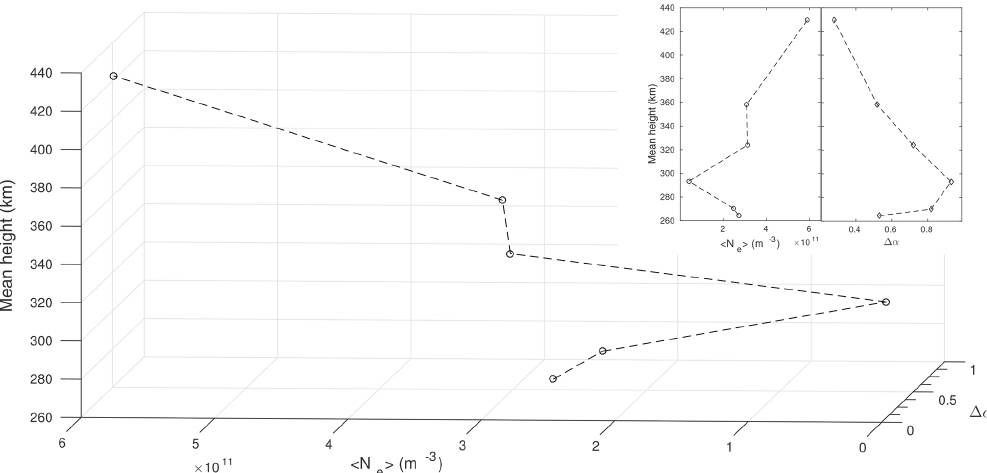
Figure 5. Variation of the mean density and the degree of multifractality with the mean height for the six selected time series from the first experiment in a 3-D plane. These variations are shown in a 2-D plane of the mean density (main image) and the degree of multifractality